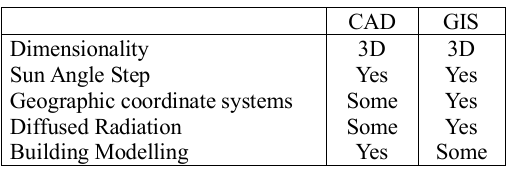
Table 1. Solar potential assessment capabilities in CAD and GIS GRASS (Geographic Resources Analysis Support System)